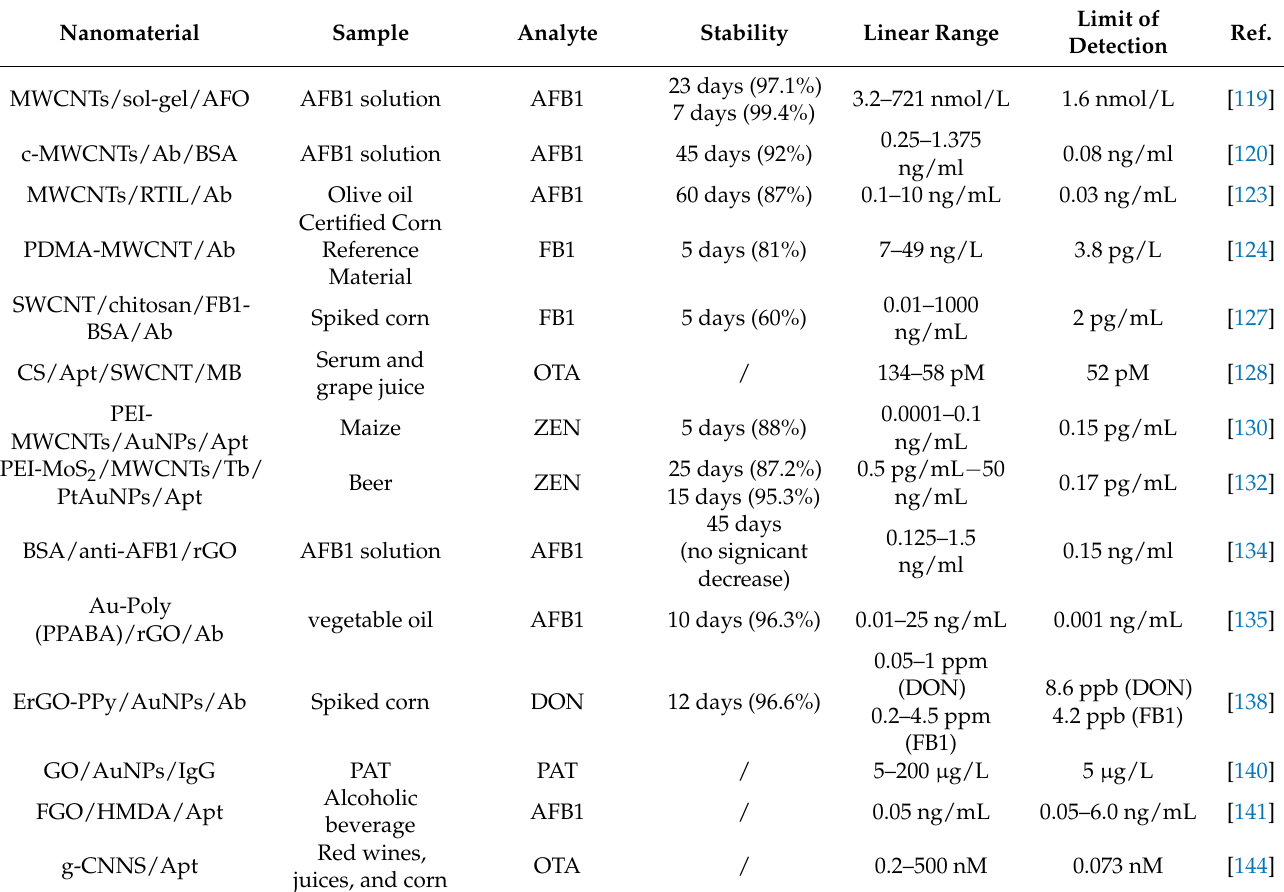
Table 7. Representative studies of electrochemical biosensor for detecting mycotoxins from food sample by carbon-based